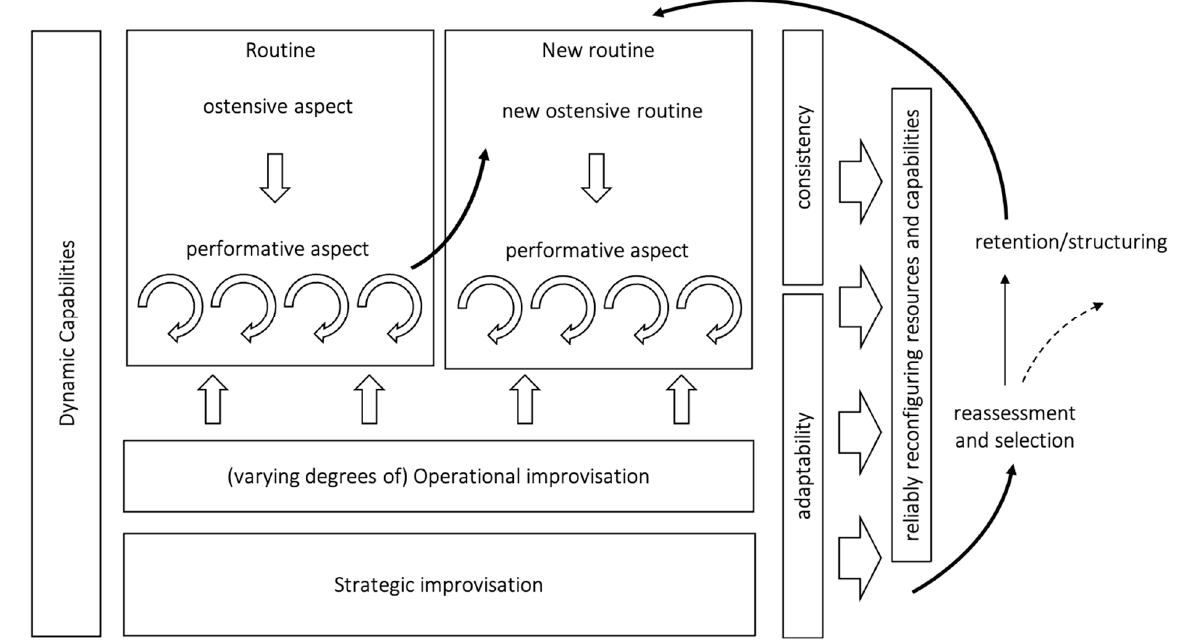
Figure 1. A duality model of Dynamic Capabilities.